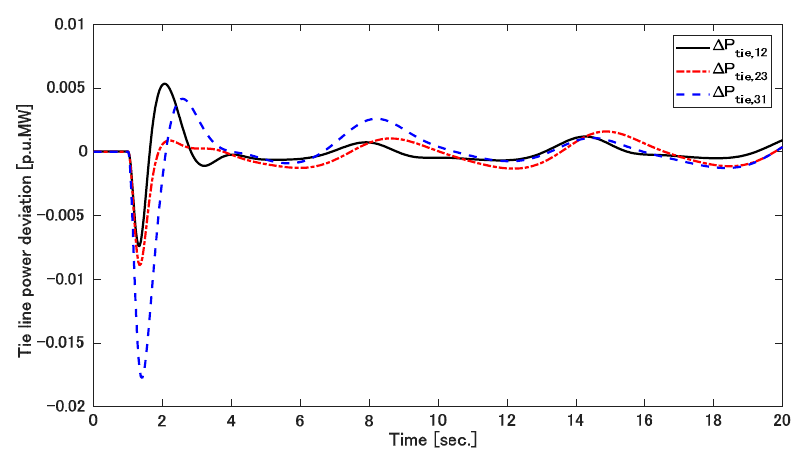
Figure 10. Tie-line power deviation of three-area power system without a wind plant.